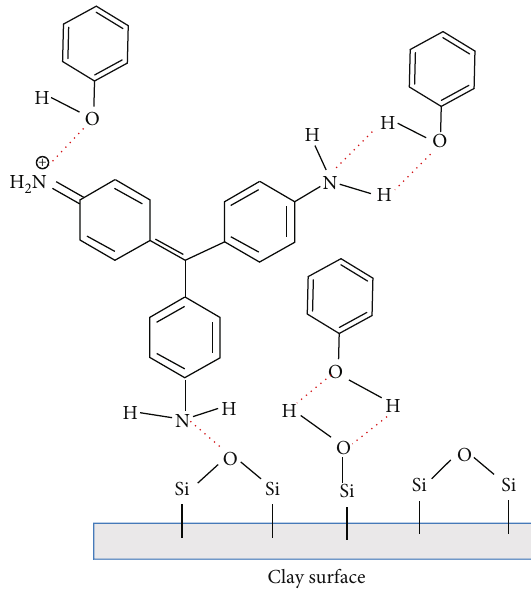
Figure 9: Synergetic e ff ect on the adsorption of phenol on GC in the presence of